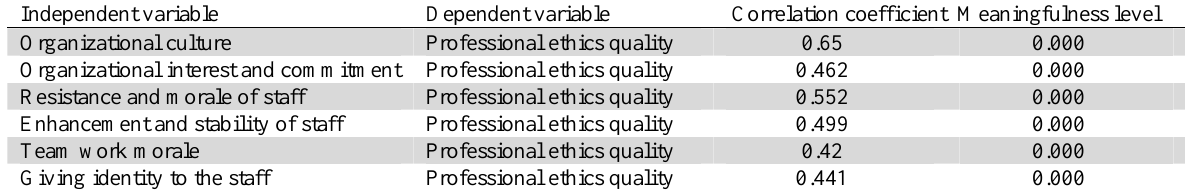
Results of correlation test between organizational culture, organizational interest and commitment